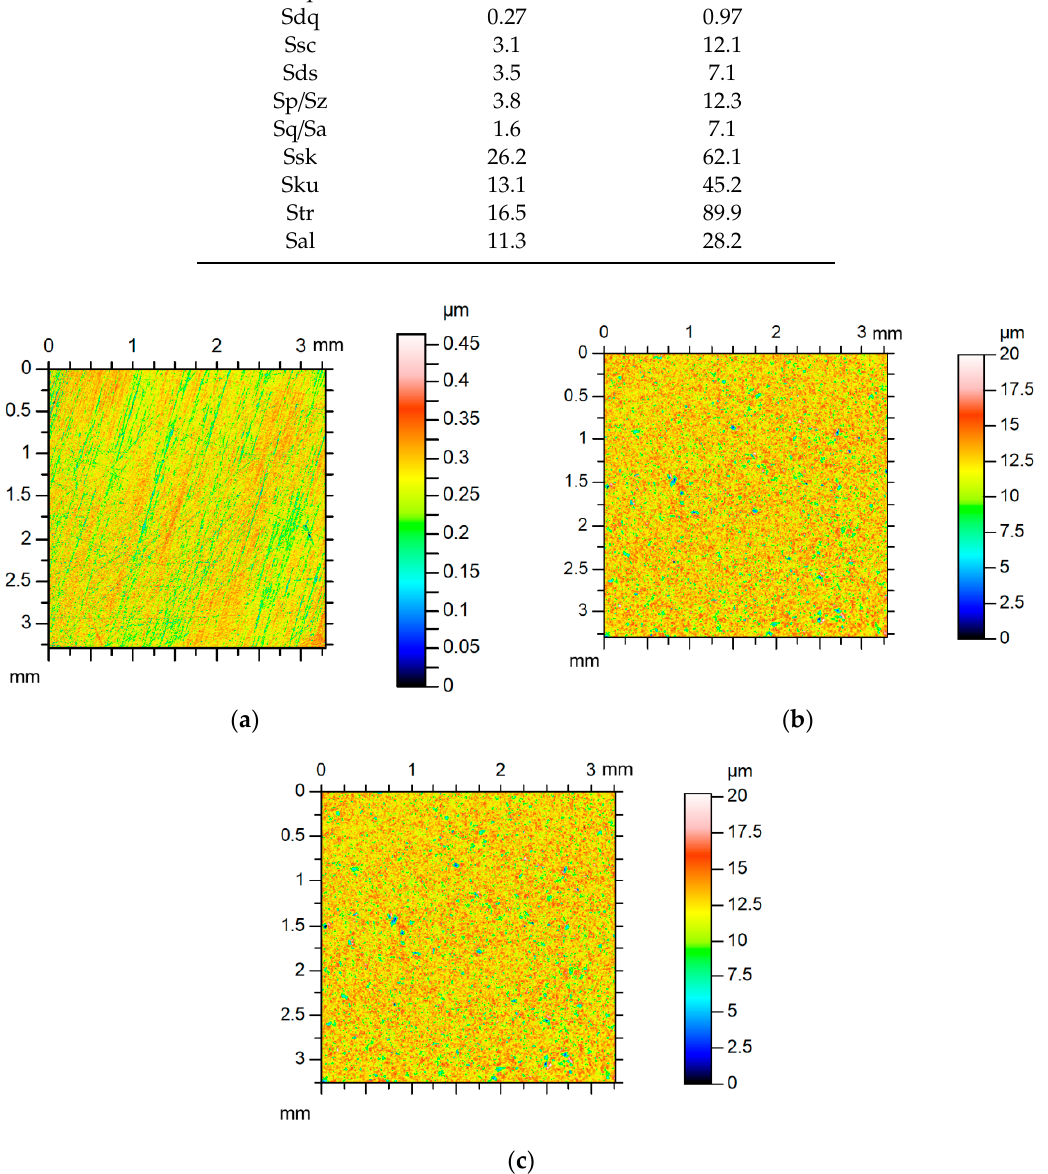
Figure 8. Contour plots of surface A ( a ), of surface B ( b ), and of equivalent sum surface ( c ).